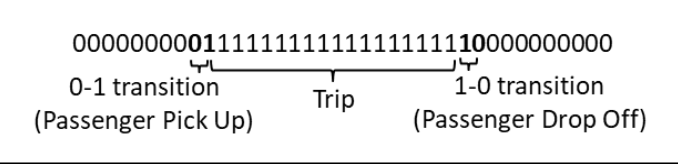
Figure 7. Passenger trip based on pick-up and drop-off transition.